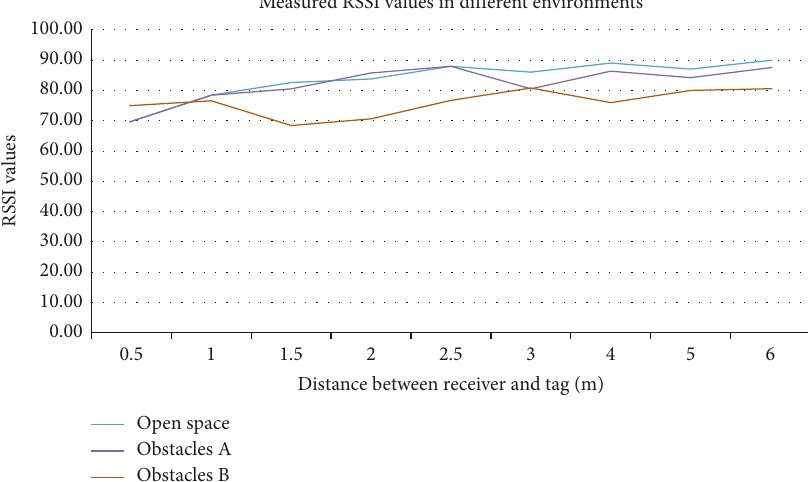
Figure 4: Multipath propagation environment: changes in received RFID signal strength vs. the distance.